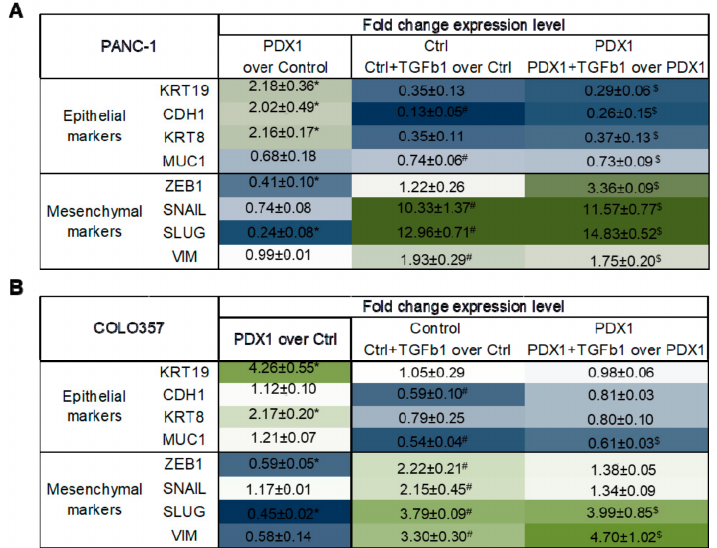
Figure 5. Changes in the expression of EMT marker genes upon treatment of Colo357 with TGF β 1 factor for 48 h. ( A ) Changes in EMT marker gene expression when PANC 1 cells were treated with TGF β 1 factor for 48 h. The data are shown as the mean of relative expression ± SD ( n = 3). *, # , $ p < 0.05 (*- PANC-1-PDX1 over PANC-1-Control, # -PANC-1-Control + TGFb1 over PANC-1-Control, $ -PANC-1-PDX1 + TGFb1 over PANC-1-PDX1). ( B ) Changes in the expression of EMT marker genes upon treatment of Colo357 with TGF β 1 factor for 48 h. The data are shown as the mean of relative expression ± SEM ( n = 3). *, # , $ p < 0.05 (*-Colo357-PDX1 over Colo357-Control, # -Colo357-Control + TGFb1 over Colo357-Control, $ -Colo357-PDX1 + TGFb1 over Colo357-PDX1). Values of relative expression are highlighted as heatmaps (green-increased expression level, blue-decreased